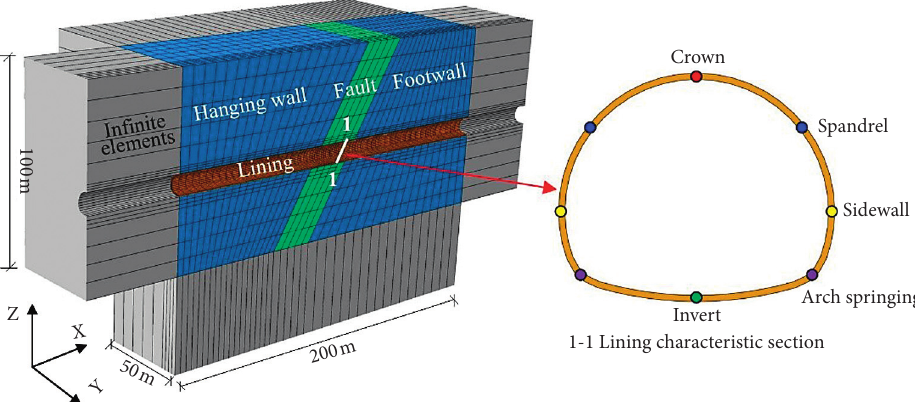
Figure 5: 3D seismic response calculation model of the tunnel crossing a fault.